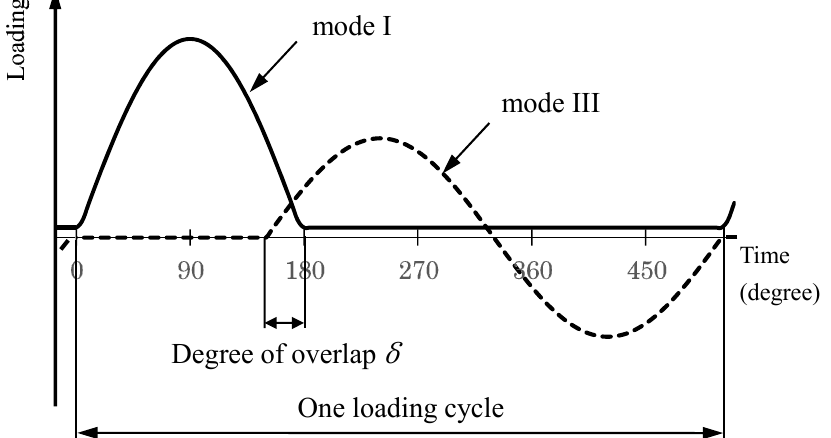
∆ K / ∆ K = 1.0 and δ = 30 ◦ III I